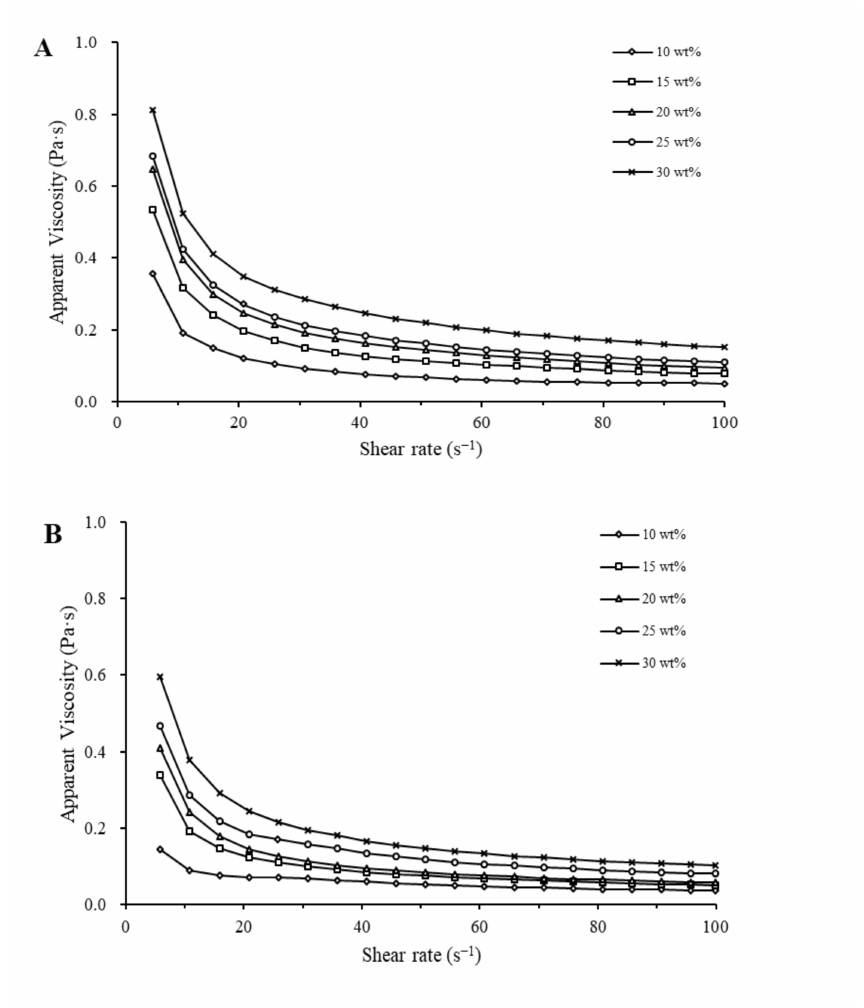
Figure 3. Interfacial protein concentration of the emulsions with glucose ( A ) and corn syrup ( B ) at different sugar